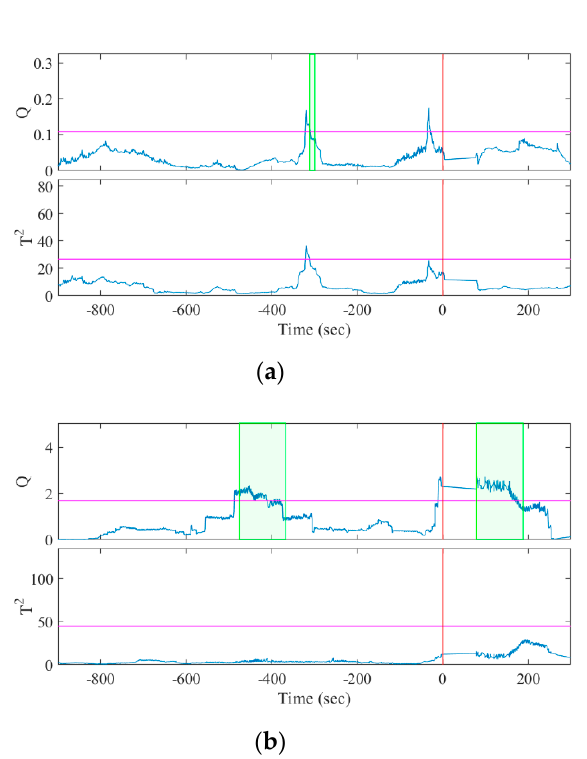
Figure 4. Results of MSPC analysis for seizure episodes ( a ) A1 and ( b ) B1. The horizontal lines and vertical lines indicate the control limits and the seizure onset, respectively. The colored bands denote C [ t ] = P , indicating the discriminated preictal